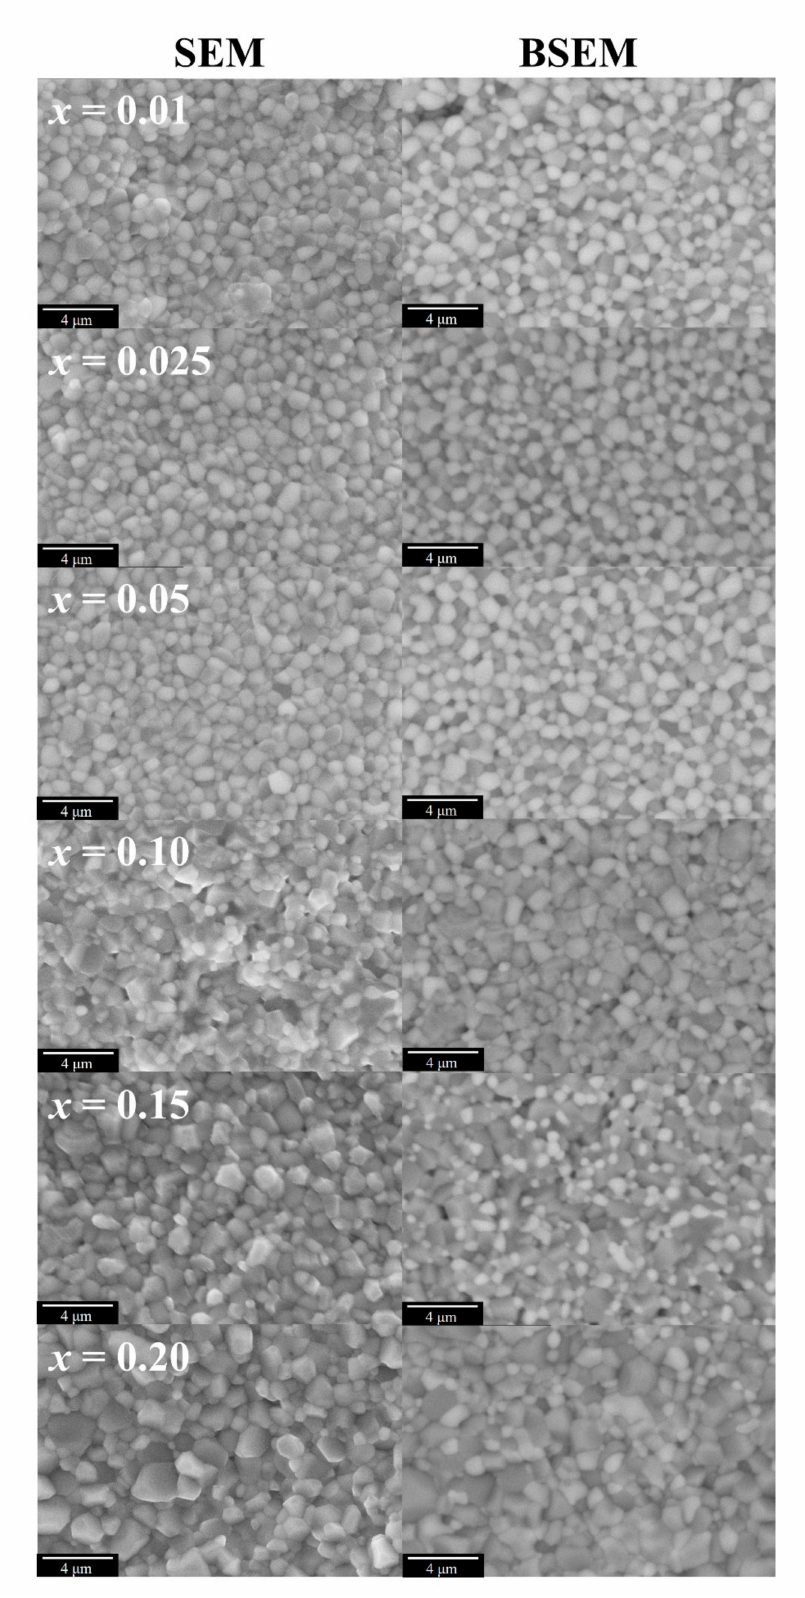
Figure 3. Surface topographies of 60CPO-40PSF 1 − x B x O membranes observed by SEM (left) and BSEM (right) after sintered (at 1400 ◦ C for x = 0.01, 0.025, and 0.05, 1350 ◦ C for x = 0.10 and 0.15, 1300 ◦ C for x = 0.20) for 5